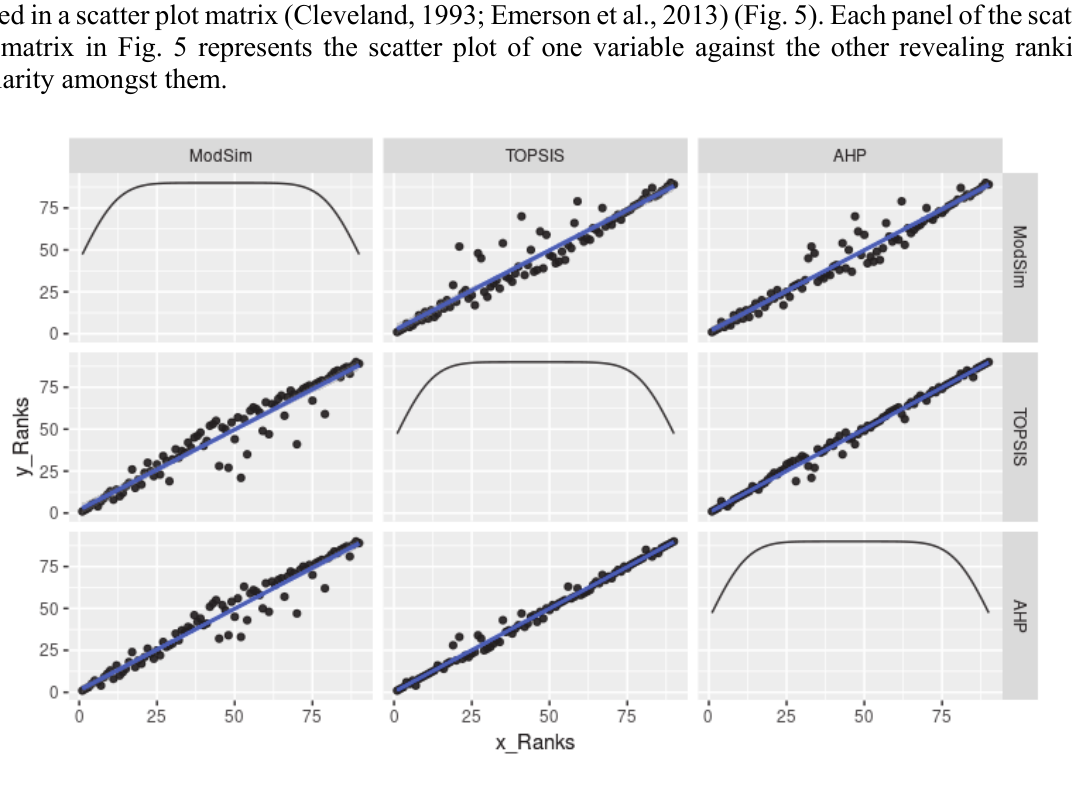
Fig. 5. A scatter plot matrix for ranks of items obtained by using modified similarity method, TOPSIS, and